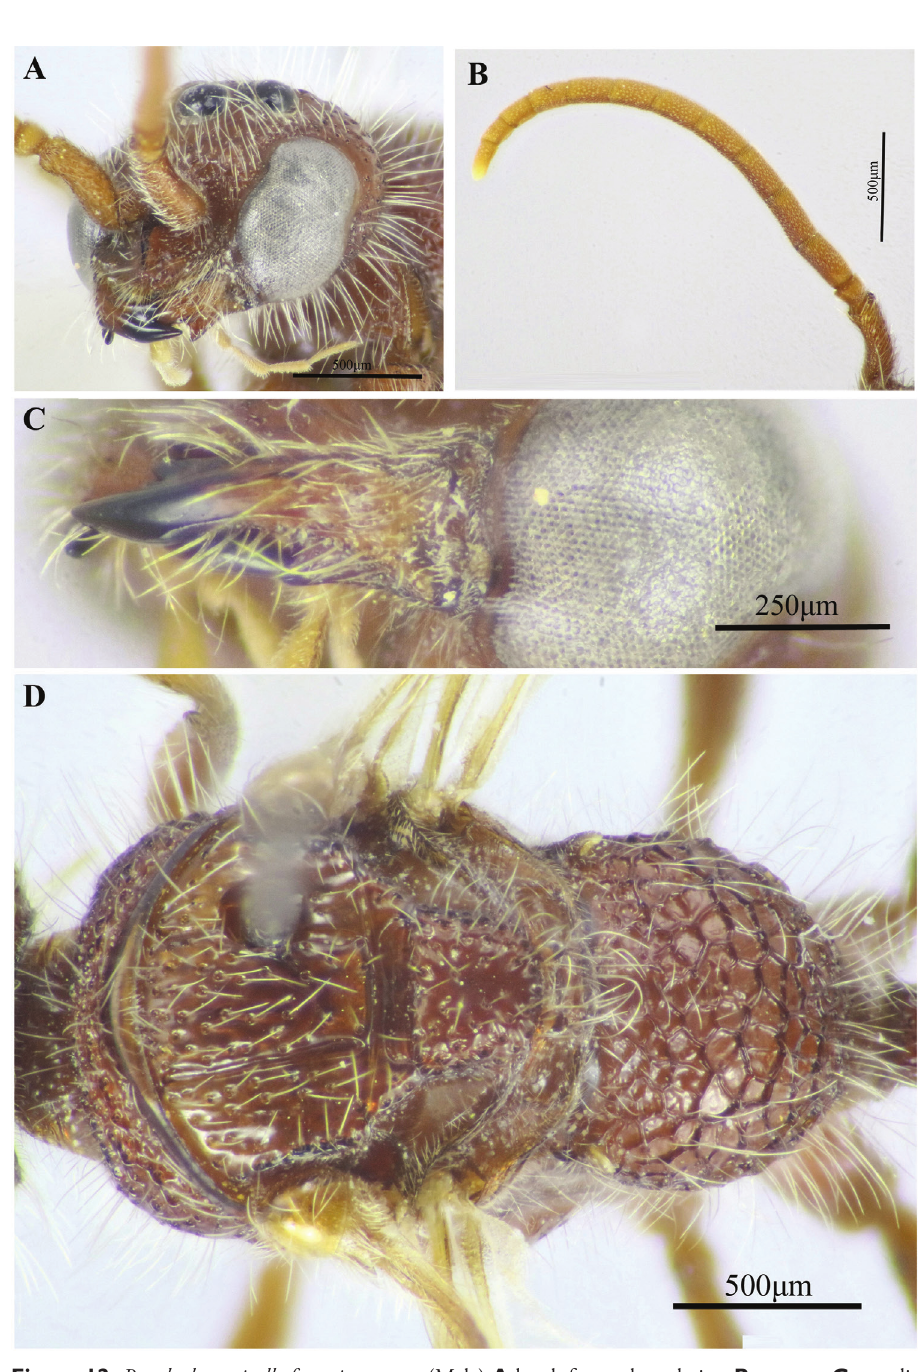
Figure 12. Pseudophotopsis dhofarensis sp. nov. (Male) A head, fronto-lateral view B antenna C mandi- ble, lateral view D mesosoma, dorsal